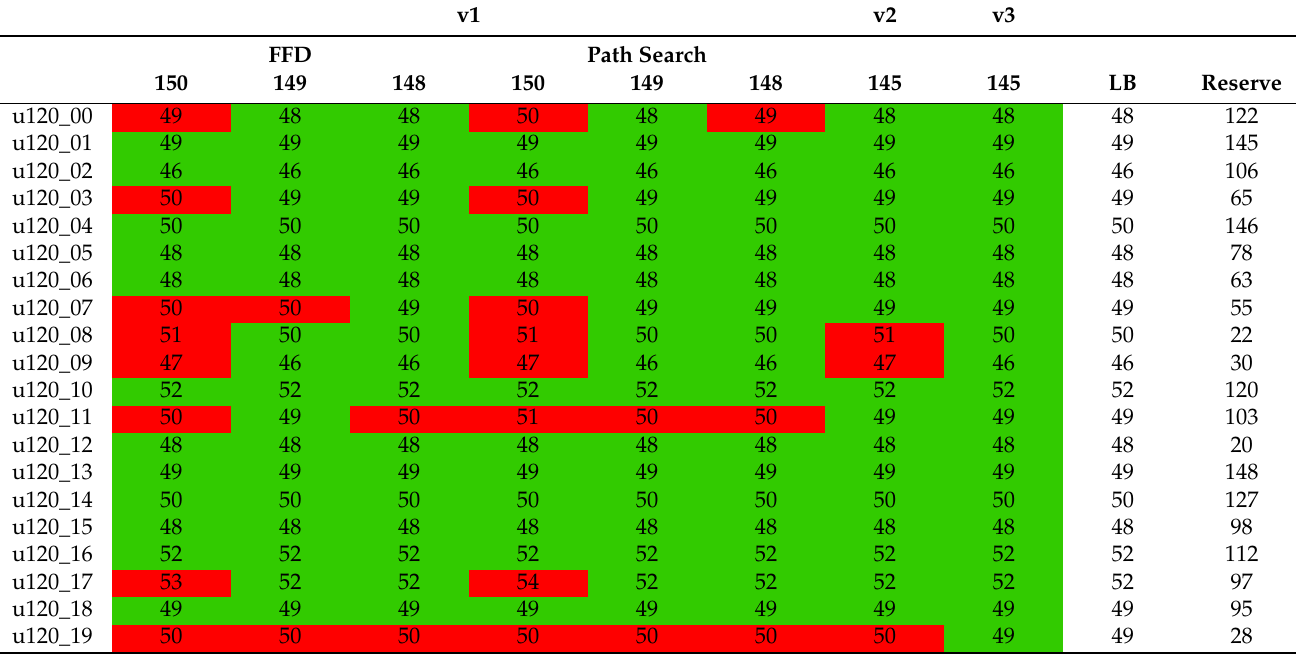
Table 6. Results of Falkenauer U120